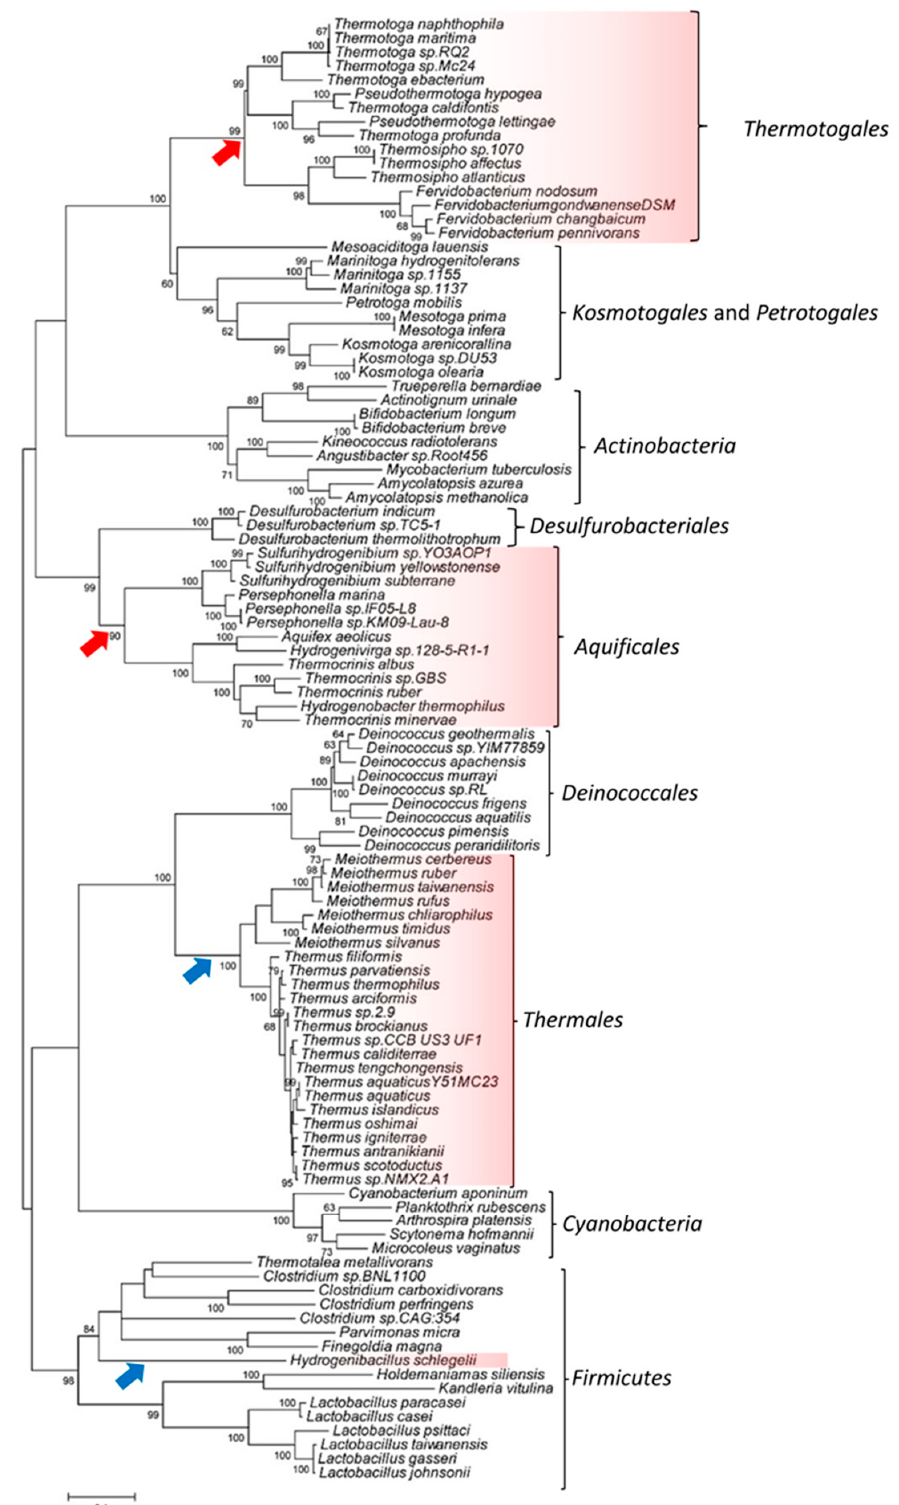
Figure 3. A maximum-likelihood phylogenetic tree based on SecA protein sequences from representative bacterial phyla. The groups of species containing the 50 aa conserved signature inserts (CSI) are marked by red arrows, whereas those containing the 76 aa CSI are denoted by blue arrows. The numbers on the nodes indicate bootstrap values for the observed groupings.